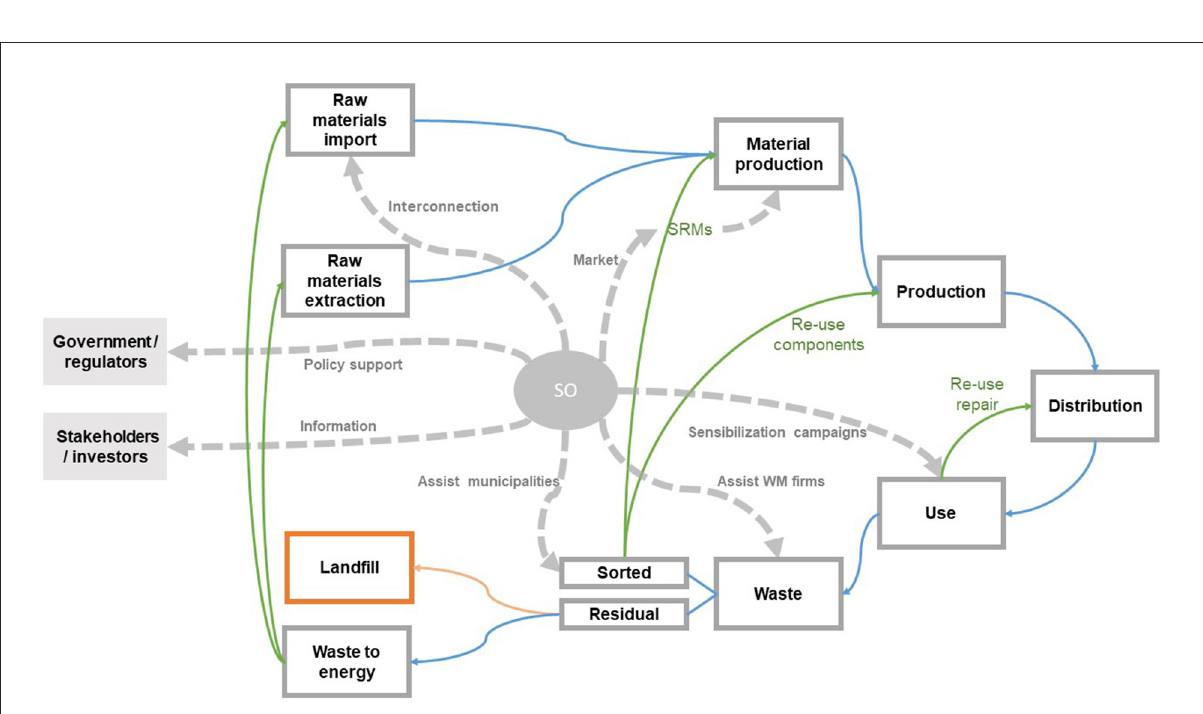
FIGURE5 Role of a SO in the waste management industry. Source: own